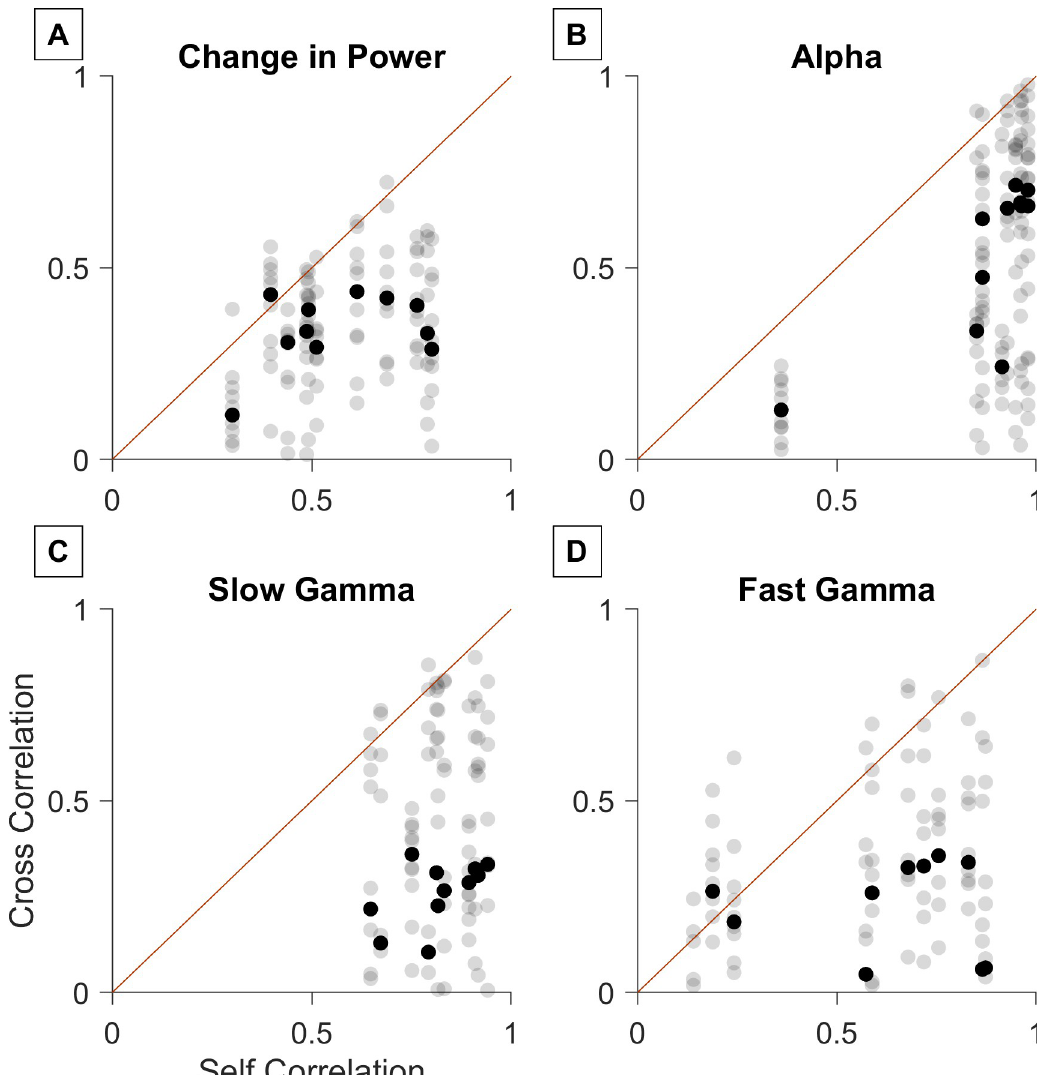
Fig 6. Comparison of self-pair correlations and cross-pair correlations. Self pair correlations (between OpenBCI and Brain Products recordings of same subjects) vs cross pair correlations (between OpenBCI and Brain Products recordings of different subjects) for change in PSD from baseline in stimulus period (A) and change in power with time for alpha (B), slow gamma (C) and fast gamma (D) bands. Red line indicates x = y line. The bold black marker indicates the median of the cross pair correlations for each